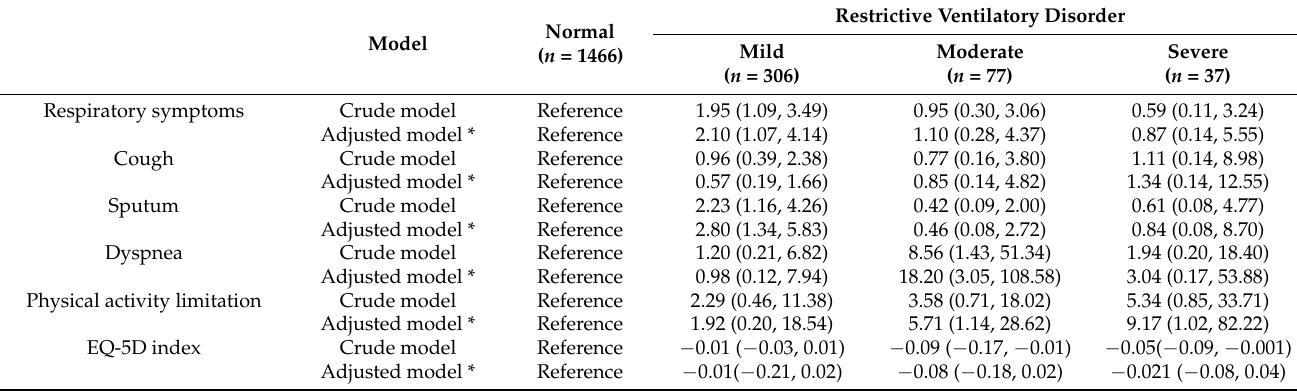
Table 4. The impact of restrictive ventilatory disorder severity on respiratory symptoms, physical activity limitations, and EQ-5D index value in subjects with prior